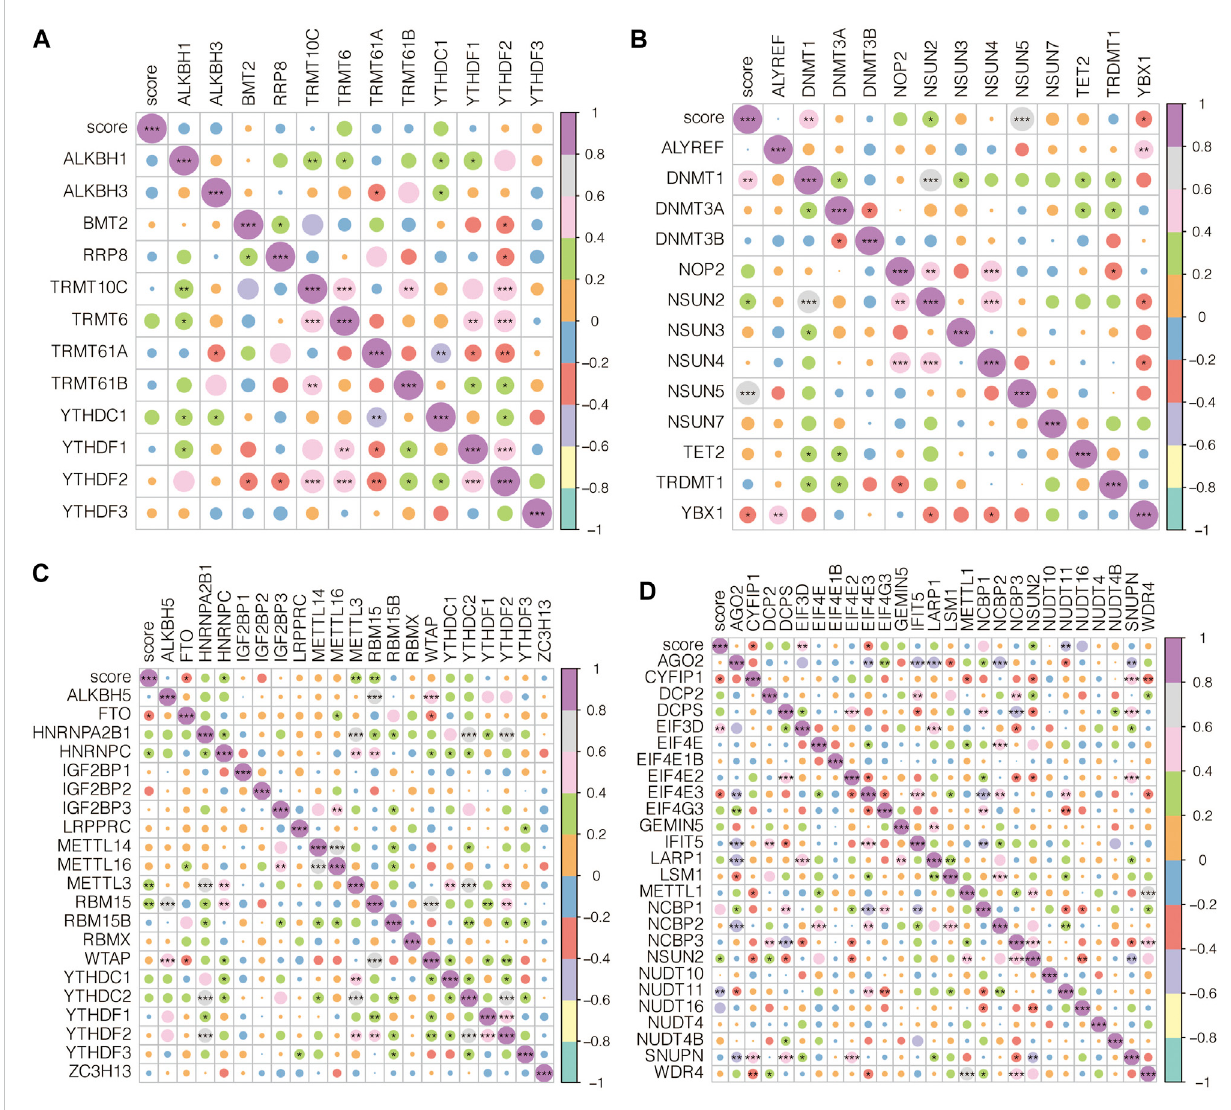
FIGURE 9 Epigenetic characteristics of AAA-related score. (A) The association between AAA-related score and m1A-related genes in GSE98278. (B) The association betweenAAA-related score and m5C-related genesin GSE98278. (C) The association between AAA-related score and m6A-relatedgenes in GSE98278. (D) The association between AAA-related score and m7G-related genes in